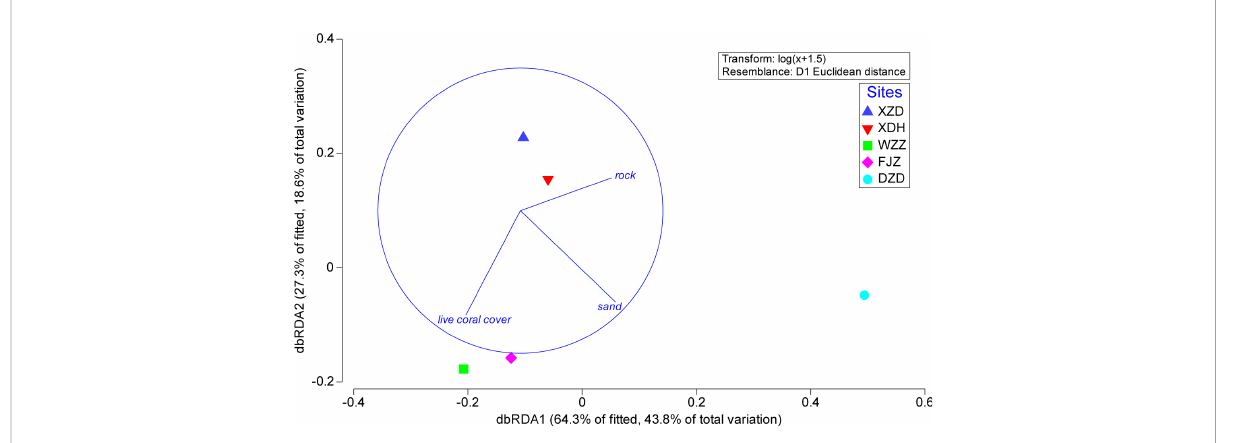
FIGURE 4 Distance-based redundancy analysis (dbRDA) of the Iviev ’ s electivity index (E i ) considering the coral prey for each station shows vector overlays of coral species preyed included in the best model by DISTLM analysis (XZD, Xiaozhoudao; XDH, Xiaodonghai; WZZ, Wuzhizhou; FJZ, Fenjiezhou; DZD,